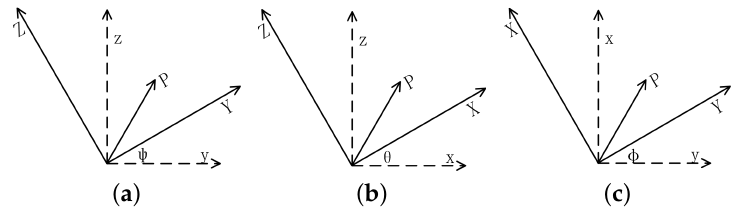
Figure 4. Rotation around the ( a ) x , ( b ) y , and ( c ) z axes of B